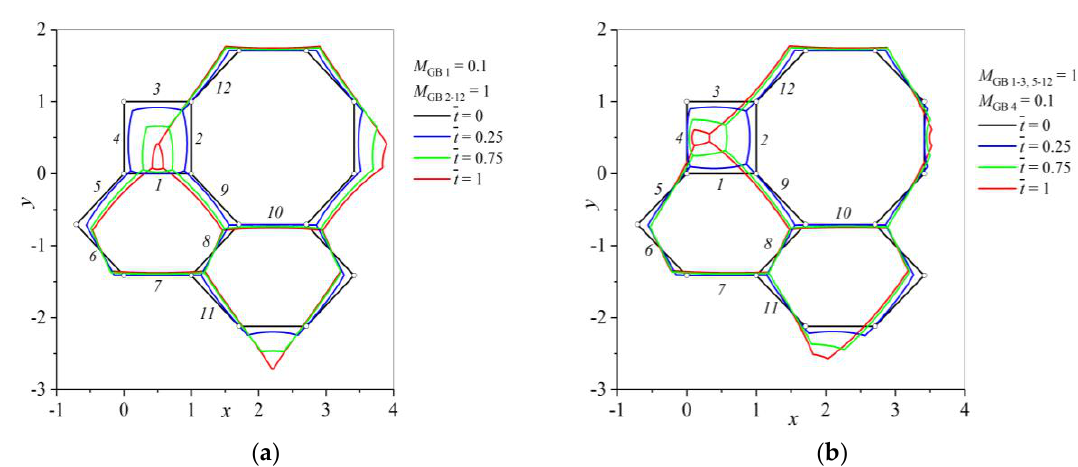
Figure 10. Evolution of the grain arrangement for di ff erent normalized times t . ( a ) Case IX: The mobilities M T 1–8 are set to value 100, whereas the mobility of grain boundary M GB 1 is set to a comparatively small value 0.1 and the remaining grain boundary mobilities M GB 2–12 are set to 1. ( b ) Case X: The mobilities M T 1–8 are set to value 100, grain boundary mobility M GB 4 is set to 0.1 and the remaining grain boundary mobilities M GB 1–3,5–12 are set to 1.